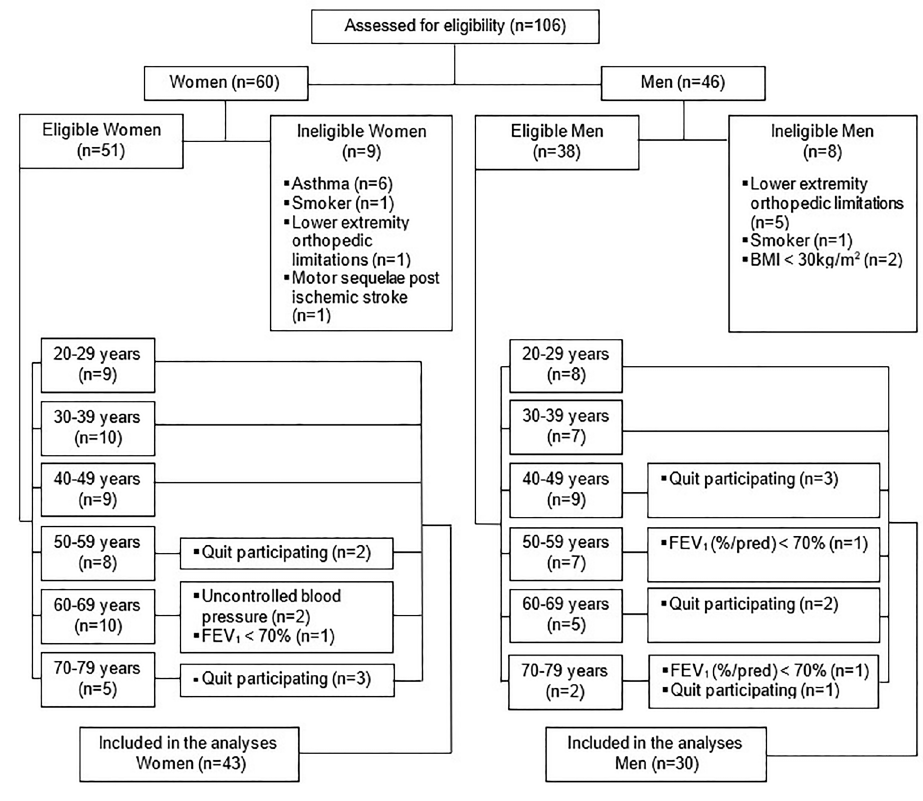
Figure 1. Volunteer recruitment fl owchart including sample